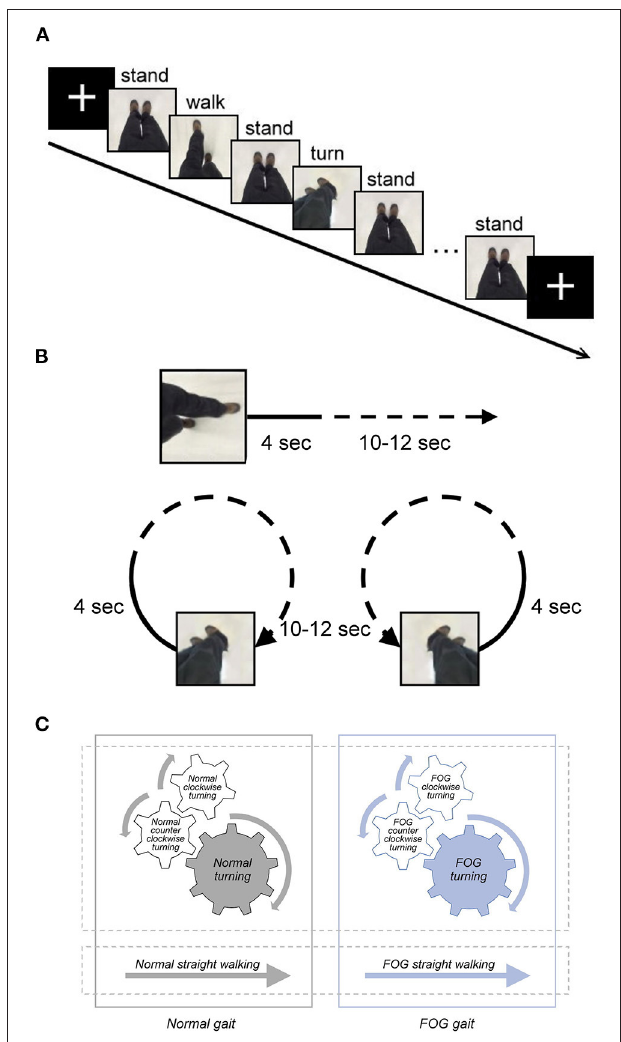
FIGURE 1 | (A) Graphical representation of the fMRI paradigm, including snapshots from the gait video clips to represent the stimulus. The duration of the stimuli, including normal straight walking , FOG straight walking (not shown in this figure), normal clockwise turning (not shown), normal counter-clockwise turning , FOG clockwise turning (not shown), and FOG counter-clockwise turning (not shown), varied between 14 and 16s. The duration of the fixed cross and standing stimuli was 5s. (B) Graphical representation of the video of FOG condition. The video clip started with normal walking or turning for 4 sec, followed by 10–12s of FOG walking or turning (70 % freezing in each FOG condition). (C) Diagram illustrating the content relationship among various gait conditions in the study. Normal clockwise turning combined with normal counter-clockwise turning together as normal turning ; FOG clockwise turning combined with FOG counter-clockwise turning as FOG turning . All FOG-related conditions, including FOG straight walking and FOG turning , were